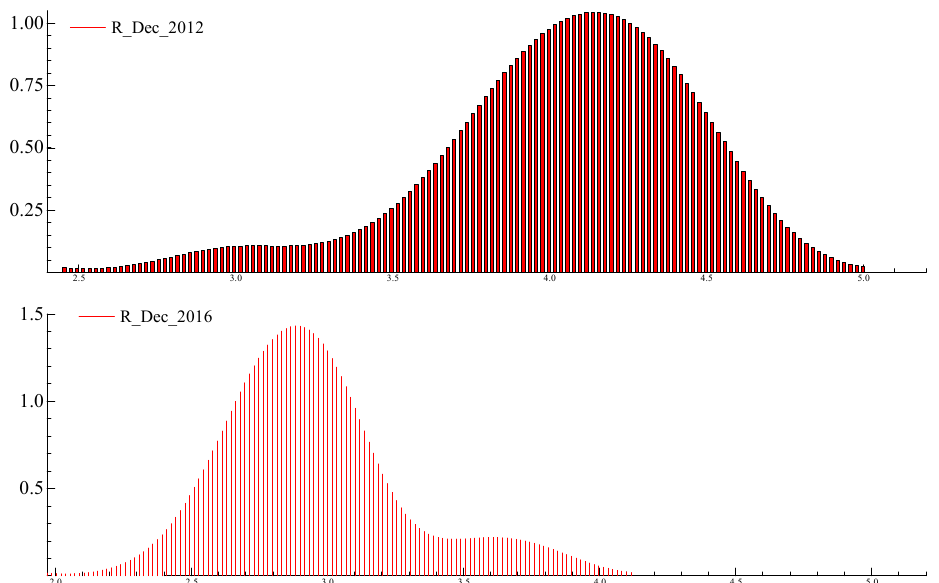
Figure 1. Marginal densities for the FOMC’s longer-run forecast for the Appropriate Interest Rate— December 2012 and December 2016.